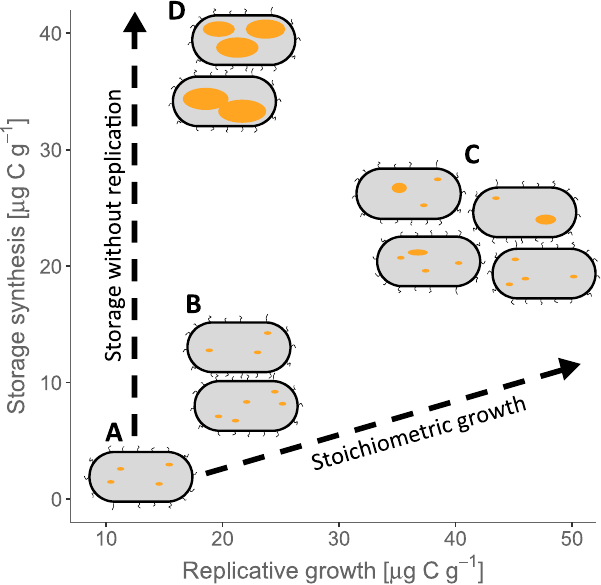
Fig. 5 | Intracellular storage represents an alternative pathway for growth of microbialbiomass. Inthisconceptual fi gurethey-coordinatesre fl ectthemeasured incorporation of added C into storage after 96h, and the x-axis represents repli- cative growth measured by 18 O incorporation into DNA (see also Fig. 4). According to contemporary assumptions, all growth should follow the stoichiometric growth curve that maintains constant element ratios in the biomass (dashed line to the right). The microbial population is shown schematically by bacterial cells, with yellowlipidinclusionbodiesrepresentingstorage.WithoutCsupply,onlylowlevels of replicative growth occur A . Low C additions (with ample nutrients) stimulate replicative growth and limited C incorporation into storage B , with the ratio of new storage to non-storage biomass staying close to that predicted by assuming con- stant biomass stoichiometry. High C addition with complementary nutrients sti- mulates both strong replicative growth as well as disproportionately large storage synthesis C ,moderatelyviolatingthestoichiometricassumption.However,nutrient limitation switches growth strongly towards storage D , incorporating C into bio- mass with little replicative growth, closer to the extreme case of pure storage without replication than the assumption of stoichiometric